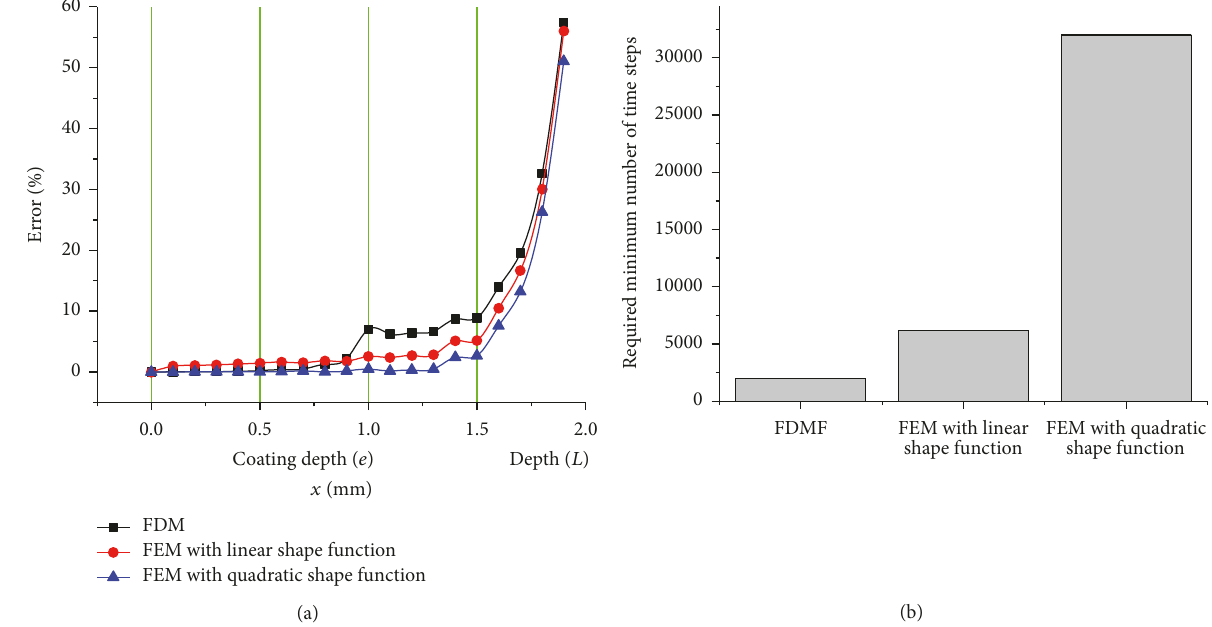
Figure 4: (a) Errors of numerical solutions. (b) Required minimum number of time